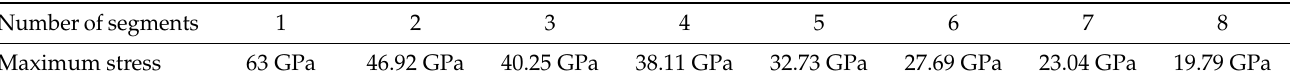
Table 7. Optimization results of maximum stress value of segmented space elevator system.